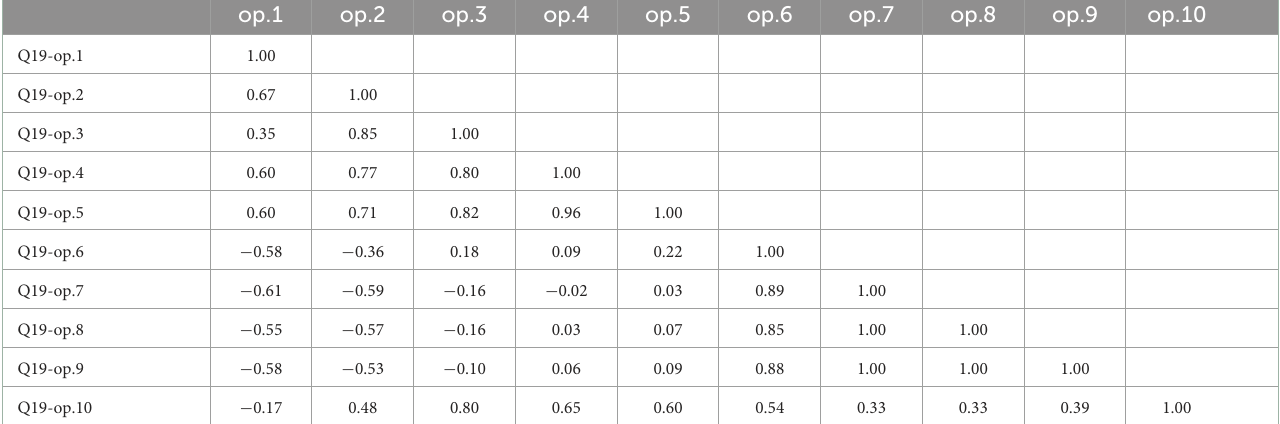
TABLE 2 Q19 “Sources used by the students to get information about the coronavirus and related topics on the Internet” correlation analysis.